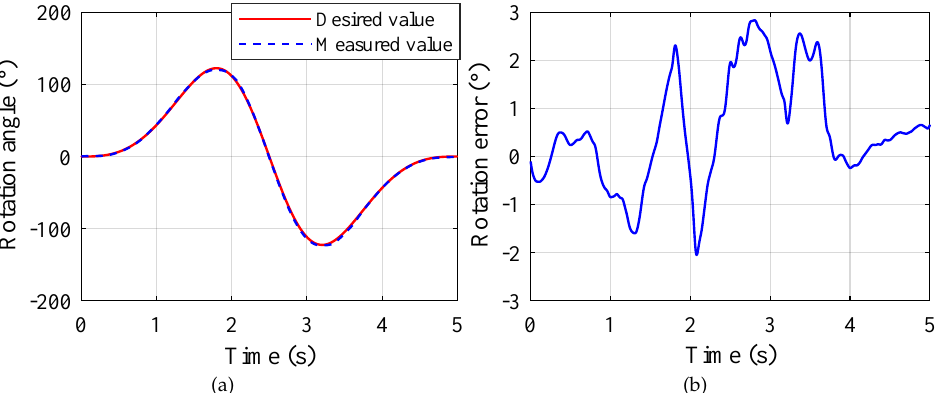
Figure 10. Rotation angle of the end-effector. ( a ) Desired value and measured value. ( b ) Rotation